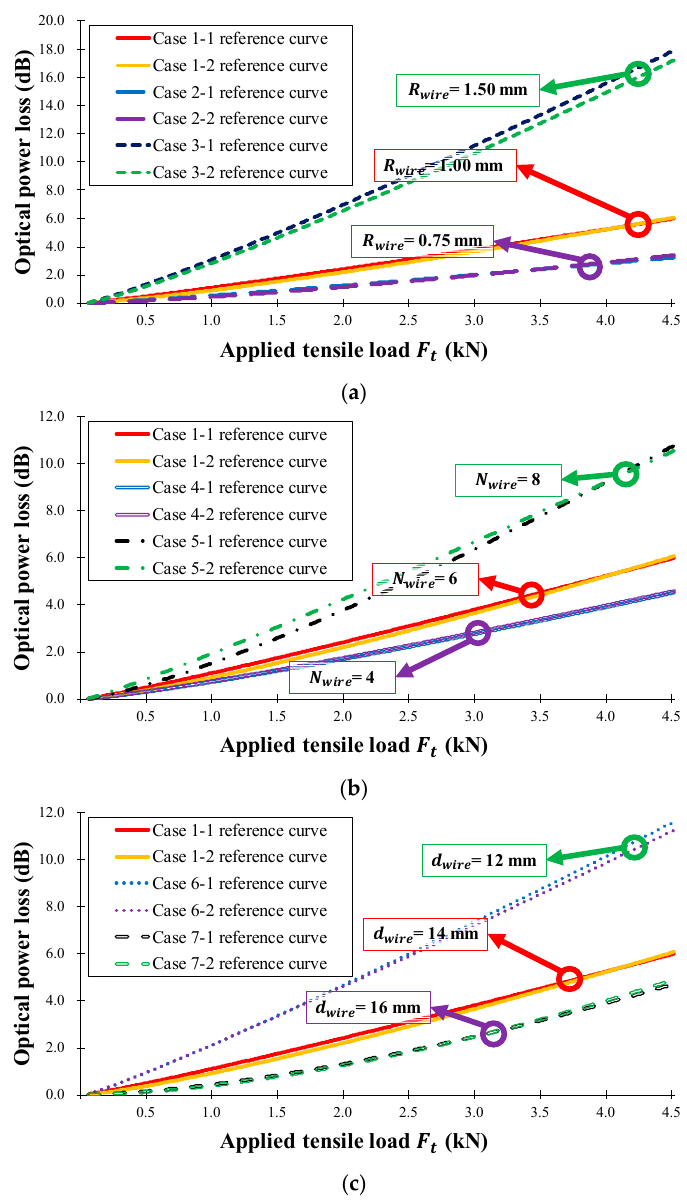
Figure 10. Measured optical power loss (dB) versus applied tensile load F t (kN) for the manufactured FOS heads in Table 1. ( a ) R wire = 0.75, 1.00, and 1.50 mm, N wire = 6, d wire = 14 mm;( b ) R wire = 1.00 mm, N wire = 4, 6, and 8, d wire = 14 mm; ( c ) R wire = 1.00 mm, N wire = 6, d wire = 12, 14, and 16 mm.